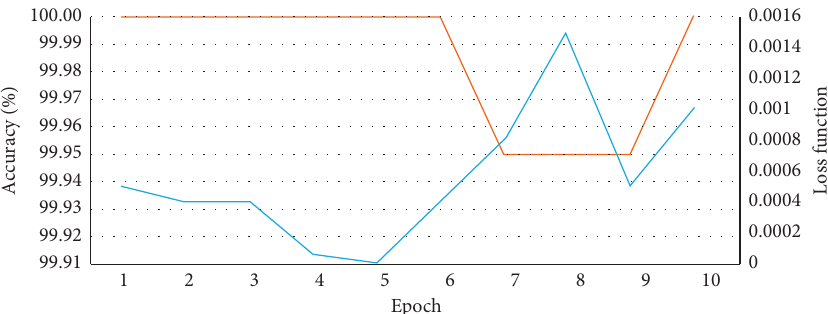
Figure 11: The loss of function gearbox dataset experiment.